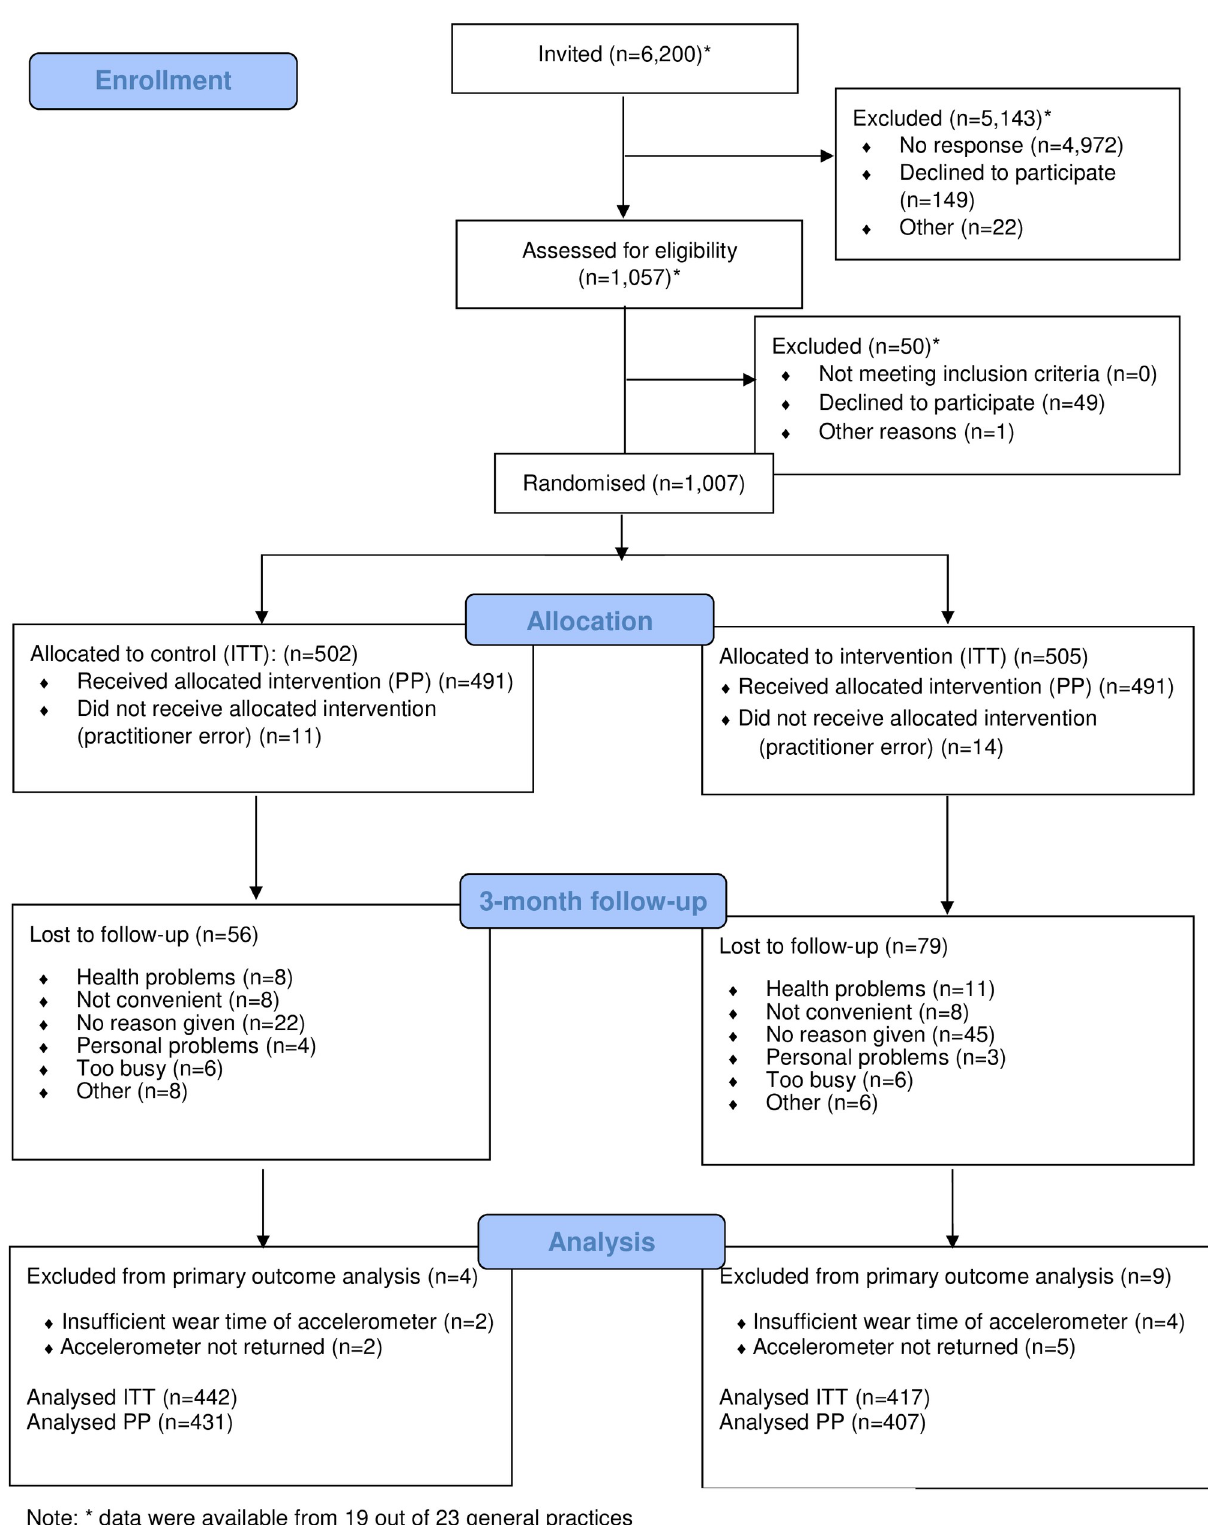
Fig 1. Flow of participants through the trial comparing the NHS Health Check plus a very brief pedometer-based intervention with the NHS Health Check only. ITT, Intention to Treat; NHS, National Health Service; PP, Per Protocol.